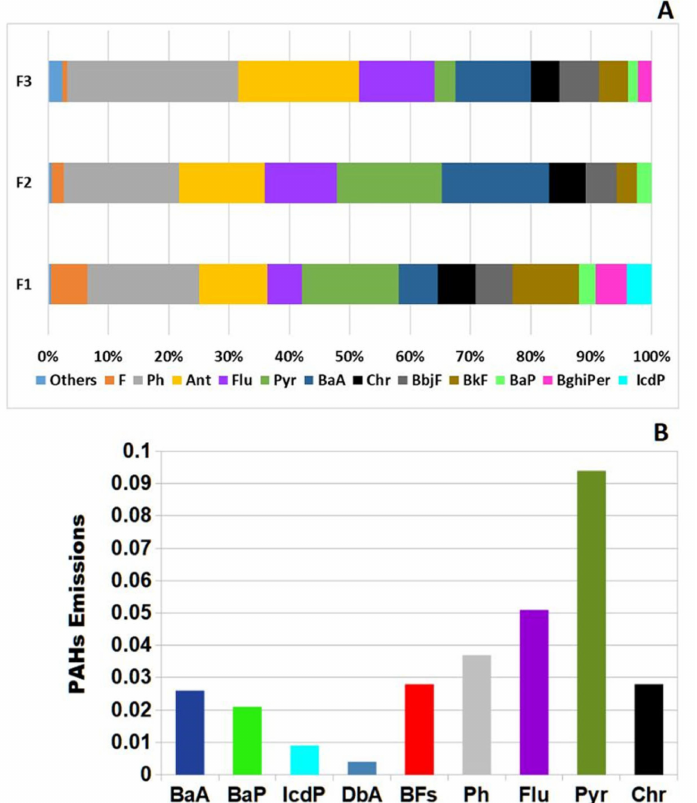
Figure 3. ( A ): PAHs’ relative abundances in sediments in F1, F2, and F3; ( B ): PAHs’ emissions from RWC (T y − 1 ) in Bragança district (source: [101]). The name of the compounds and respective abbreviations are presented in Table